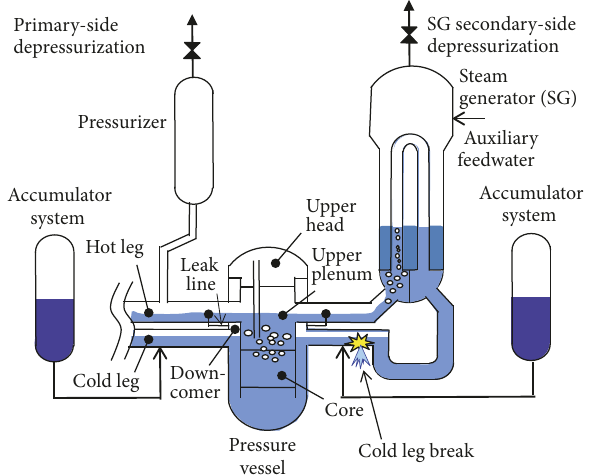
Figure 1: Coolant behavior during SBO transient with loss of pri- mary coolant and AM measure